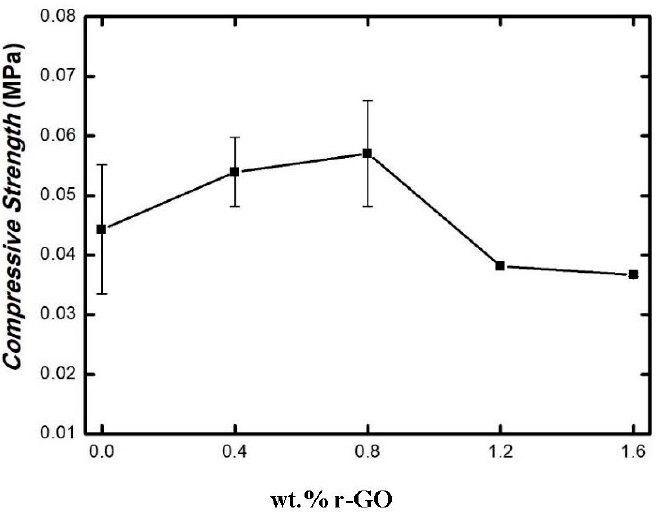
Figure 4. Compressive Strength vs. wt.% r-GO of the Studied Composites.